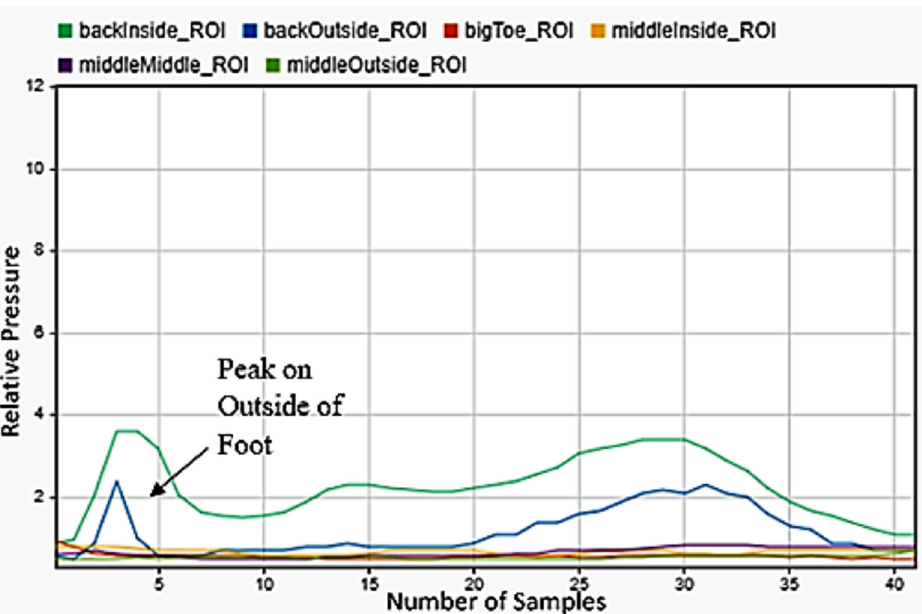
Figure 16. Falling to the right sensor data for the right foot.